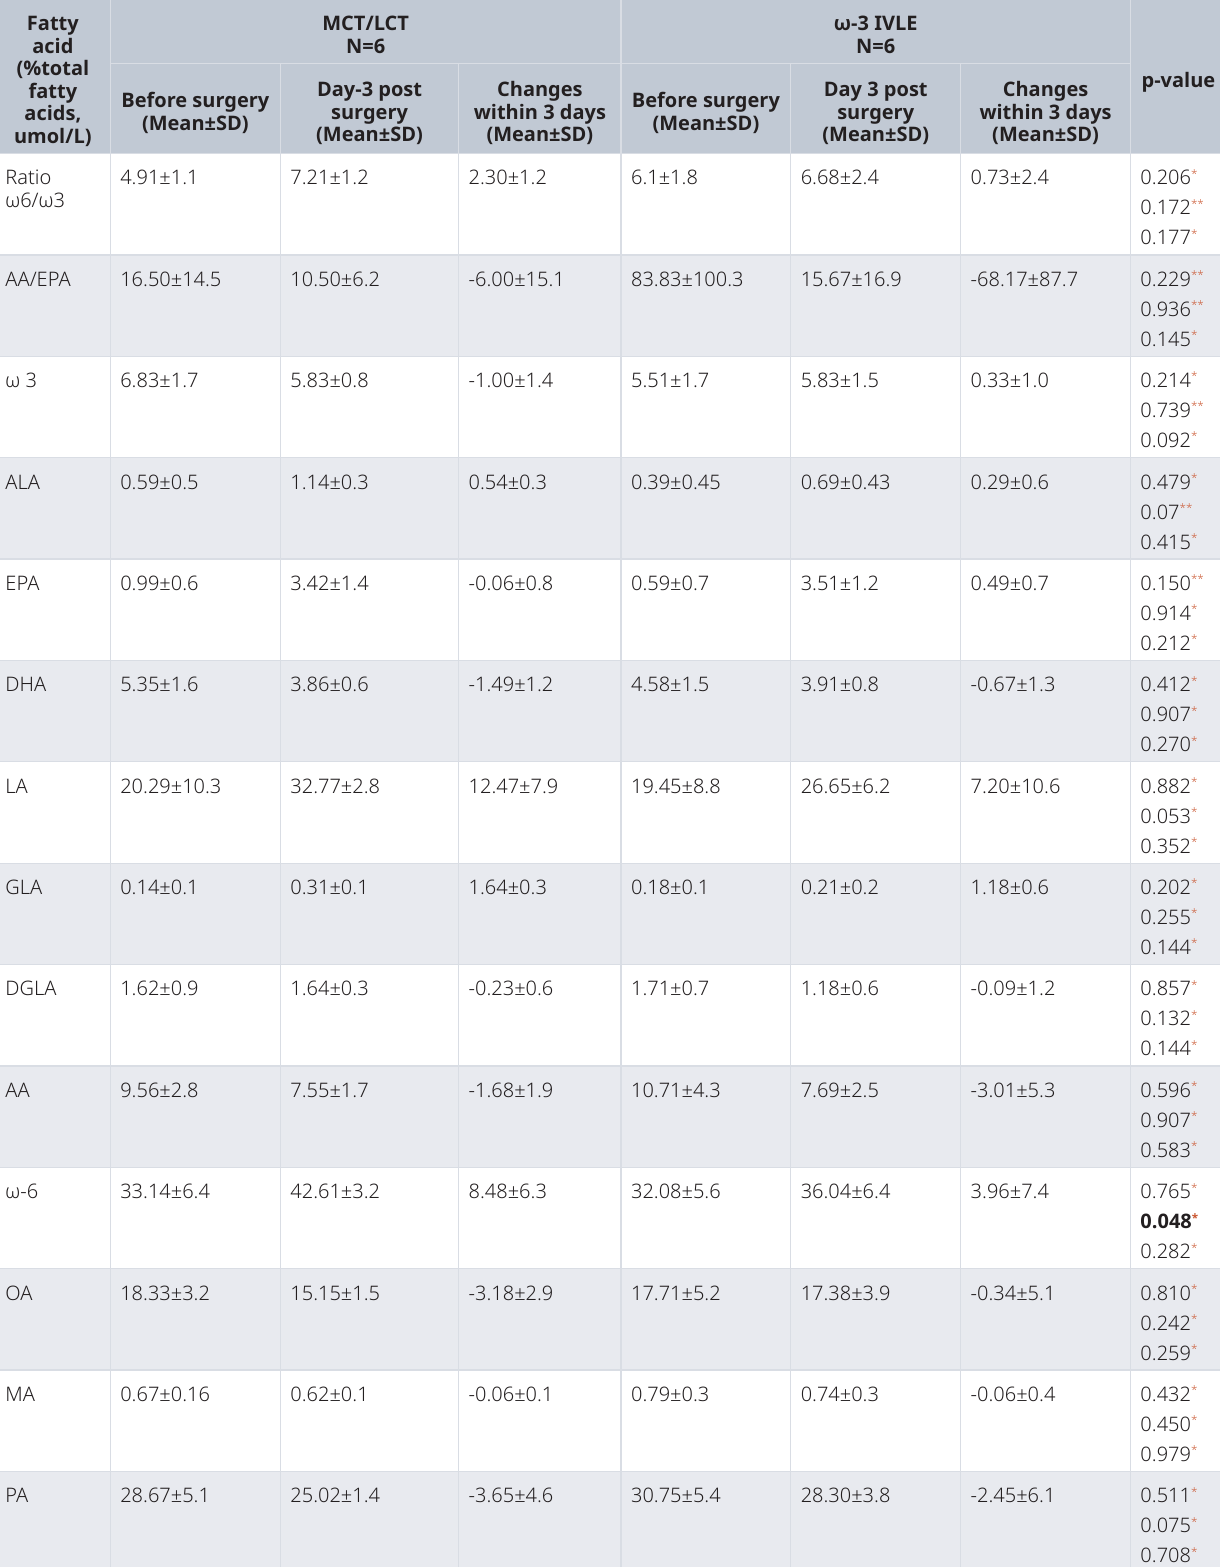
Table 4. Serum fatty acid between standard and omega-3 enriched intravenous lipid emulsion. Fatty